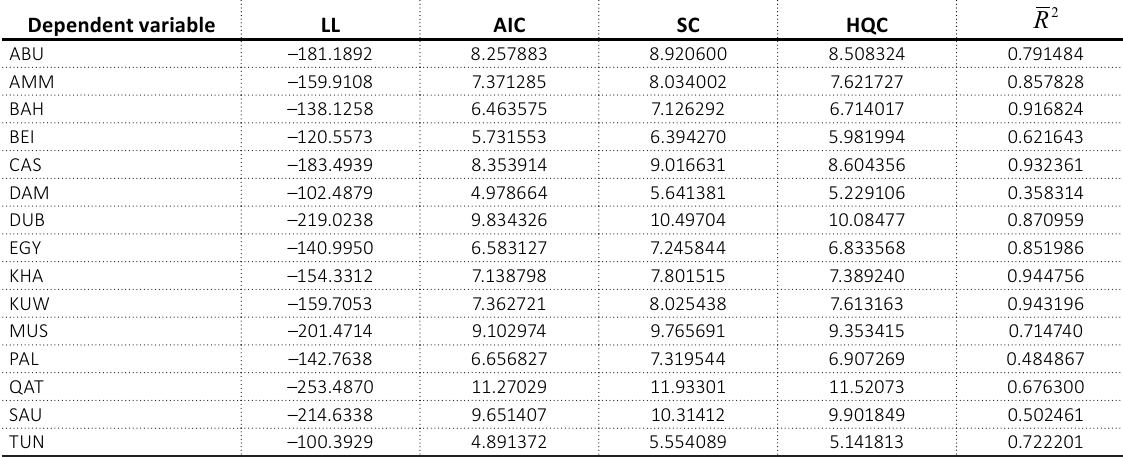
Table 6. Summary results of model estimation, Model 1: TARCH